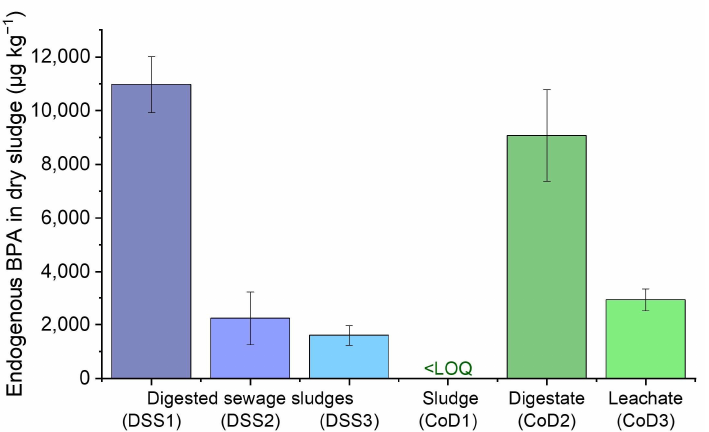
Figure 4. Endogenous bisphenol A concentration of various sludges (dry weight). Standard devia- tions of triplicates are represented by error bars.